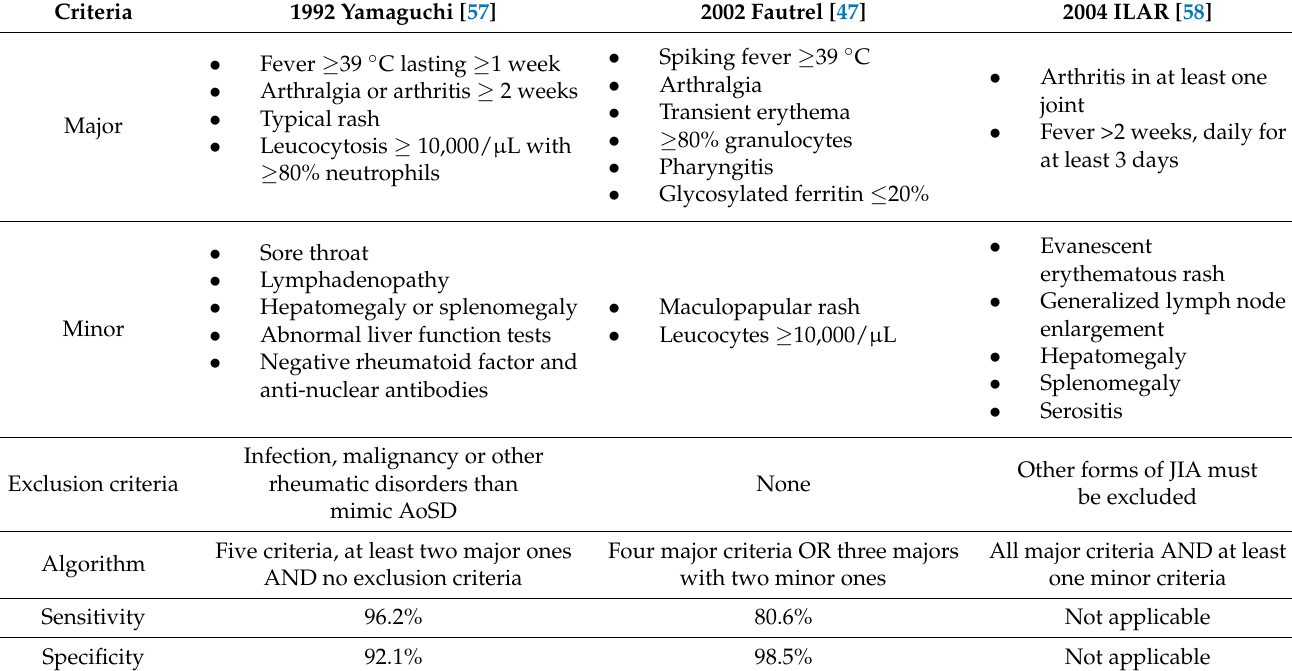
Table 3. Classification criteria for AoSD and the revised definition of the International League of Associations for Rheuma- tology (ILAR) diagnostic criteria for